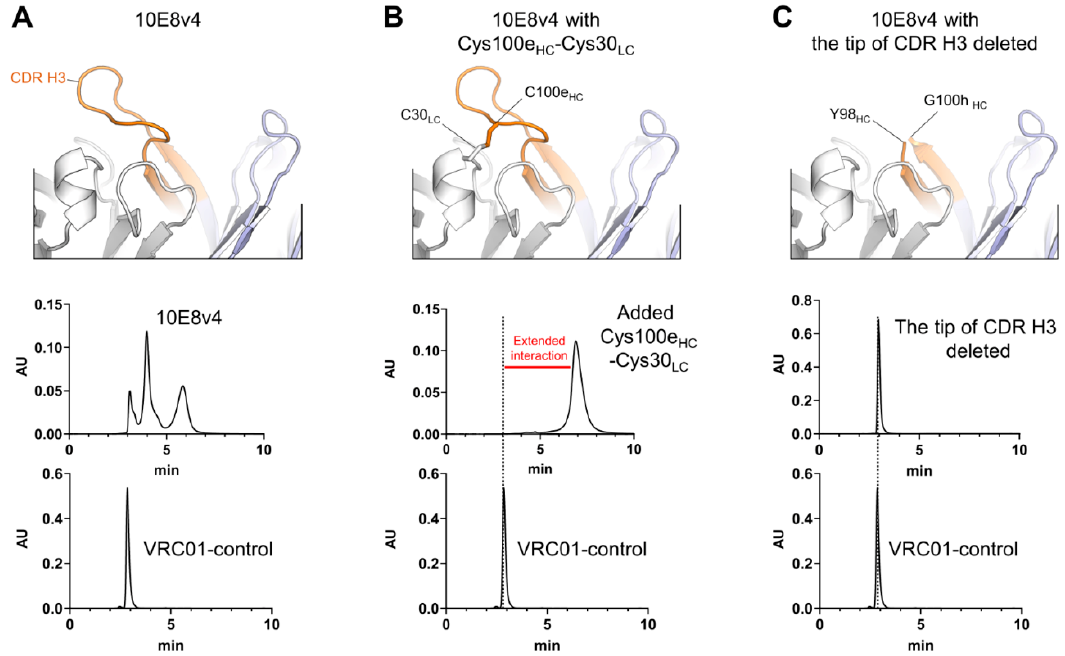
Figure 1. CDR H3 of 10E8 is the cause of extended interaction with SEC. ( A ) Top panel, crystal structure of 10E8v4 (PDB ID:5IQ9); bottom panels, anomalous SEC profile of 10E8v4 versus antibody VRC01 control. ( B ) After introducing a disulfide bond by mutation of CDR H3 (Tyr100eCys) and light chain (Ser30Cys), a single peak of the 10E8v4 modified Cys100e HC -Cys30 LC was observed, but with anomalously longer SEC profile compared to antibody VRC01. Top panel, model of the disulfide bond linked CDR H3; bottom panels, SEC chromatography of 10E8 variant highlighting anomalous SEC interaction versus antibody VRC01 control. ( C ) Deletion of the tip of CDR H3 ( 99 YDFWFGYPP 100g ) leads to loss of extended SEC interactions. Top panel, model of the 10E8v4 structure with the tip of CDR H3 deleted; bottom panels, SEC chromatography of 10E8 variant highlighting anomalous SEC interaction versus antibody VRC01 control.